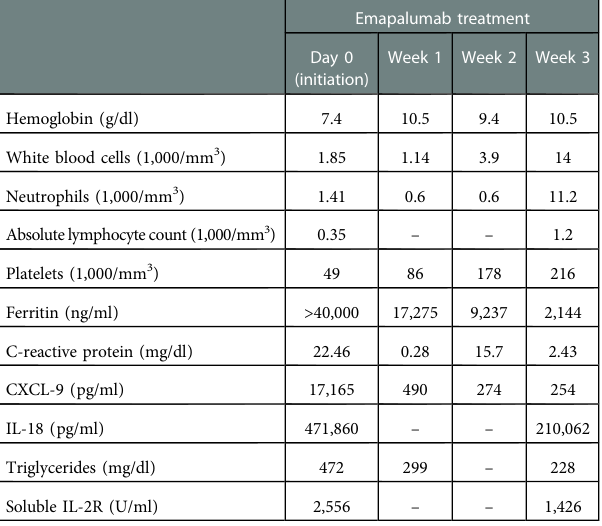
TABLE 1 Laboratory parameters during emapalumab treatment.